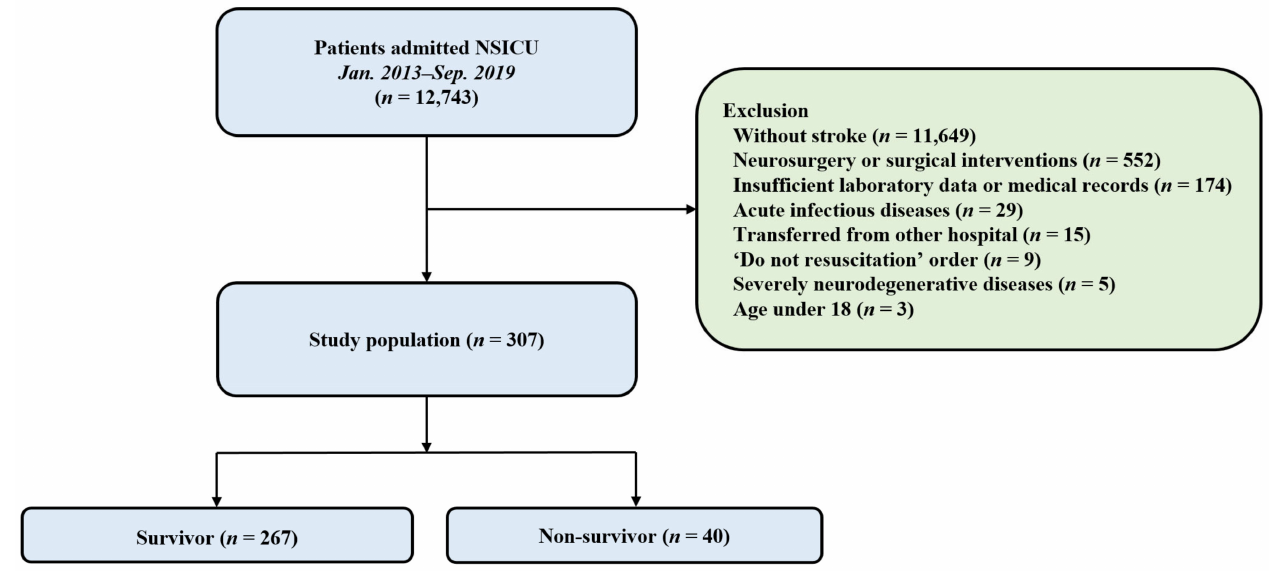
Figure 1. A flowchart of the study. A total of 12,743 patients admitted to the NSICU were enrolled, and 307 patients were included for the analysis. NSICU, Neurosurgical intensive care